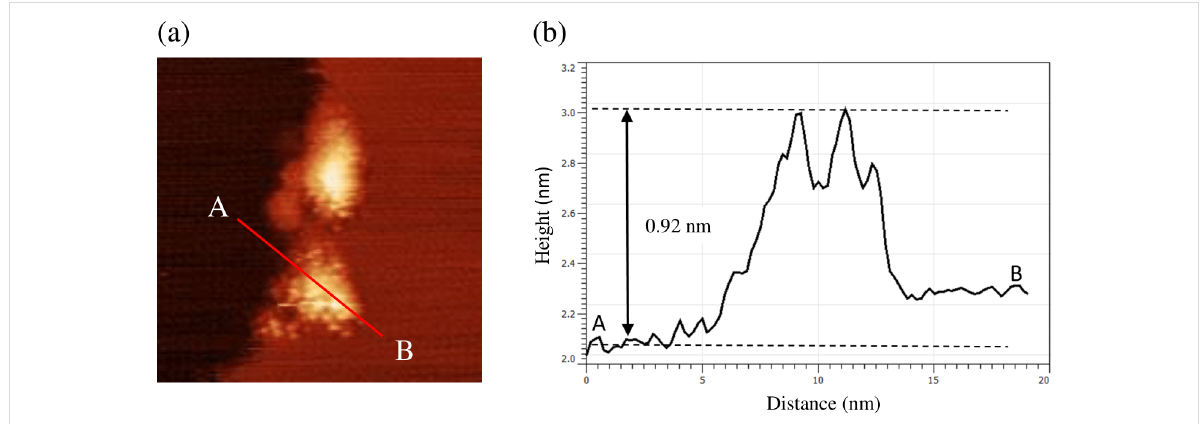
Figure 4: (a) Magnified image of the island in (d) of Figure 3. (b) Line profile along the line A–B in (a).